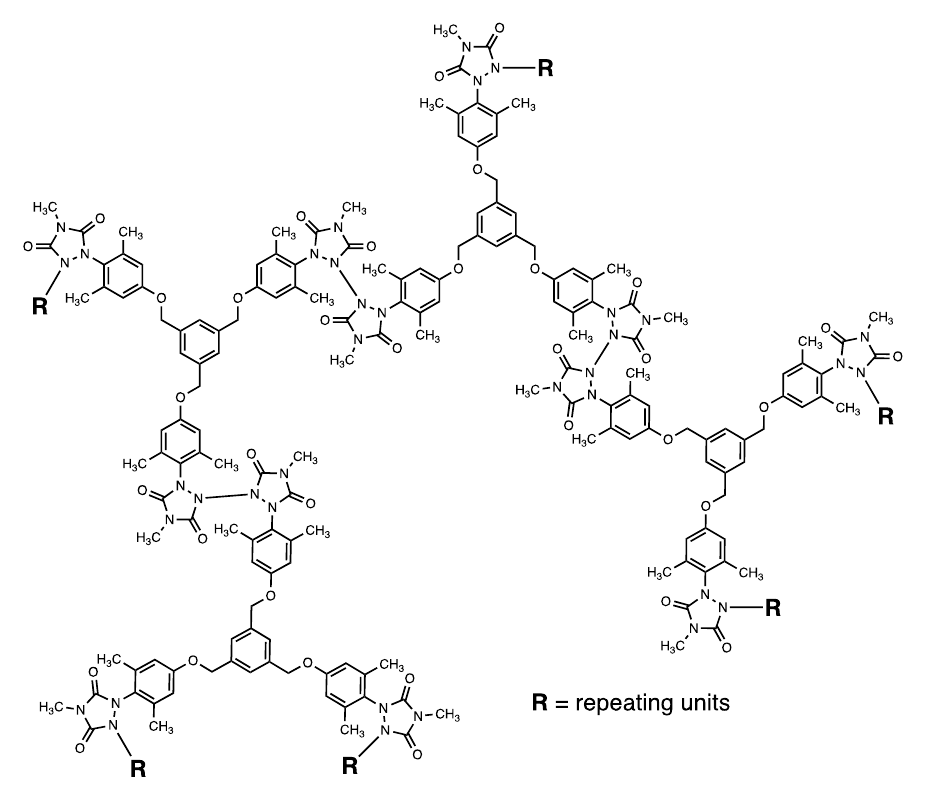
Figure 2. Representation of plastic-like material resulting from random oligomerization of radical sites via N-N bond formation.